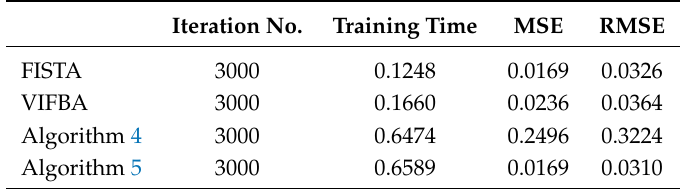
Table 6. Numerical results of a regression of a sine function at the 3000th iteration. Iteration No.